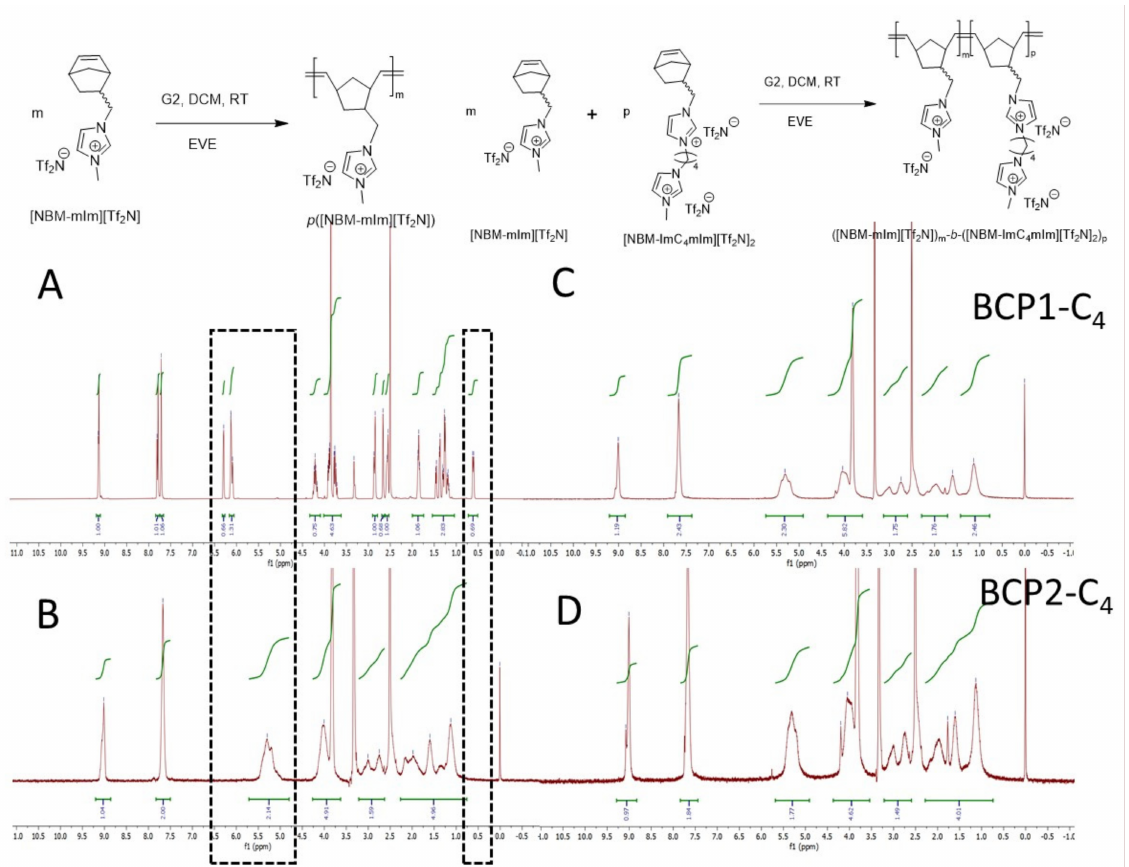
Figure 2. 1 H NMR spectra before ( A ) and after ( B ) homopolymerization of [NBM-mIm][Tf 2 N]. 1 H NMR spectra of ([NBM-mIm][Tf 2 N] m - b -([NBM-ImC 4 mIm][Tf 2 N] 2 ) p ) at different equivalents (when m = 1 eq then p = 0.11 or 0.25 eq). ( C ) BCP1-C 4 and ( D ) BCP2-C 4 where 1 and 2 corresponds to 0.11 and 0.25 eq of ([NBM-ImC 4 mIm][Tf 2 N] 2 ),